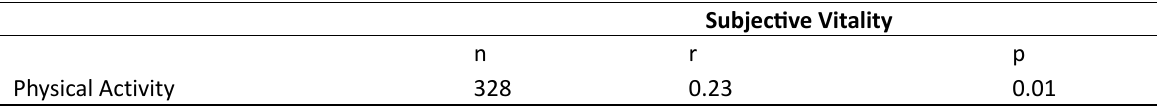
Diagram 4. Scores of participations in physical activity by department Table 2. Relationship between physical activity and subjective